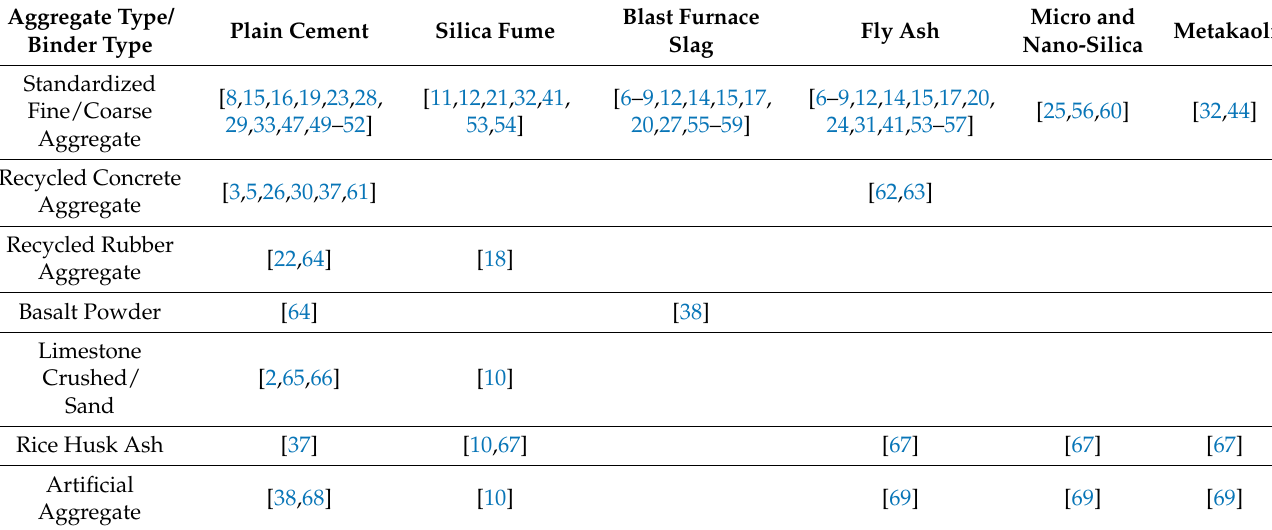
Table 2. Various types of concrete mixtures investigated using